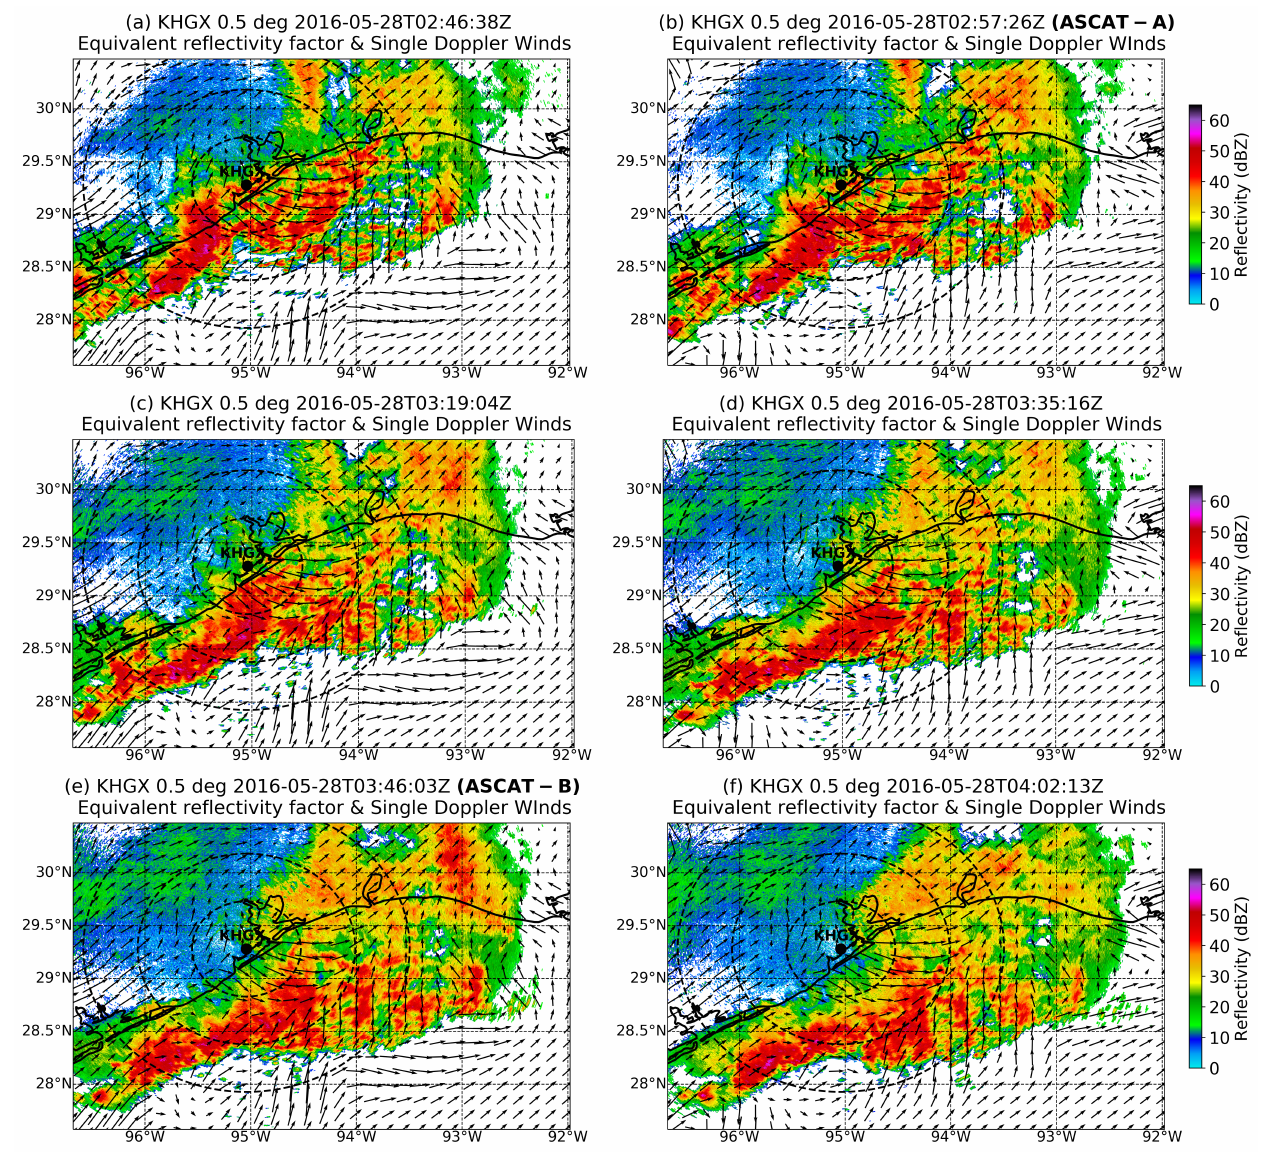
Figure 1. Time series depiction of reflectivity field and single-Doppler winds for KHGX radar station. Concentric circles (black dashed) are drawn at 50 km intervals, i.e., at a distance of 50, 100 and 150 km from the radar location. ( b , e ) correspond to the closest times of the ASCAT-A and -B overpass,